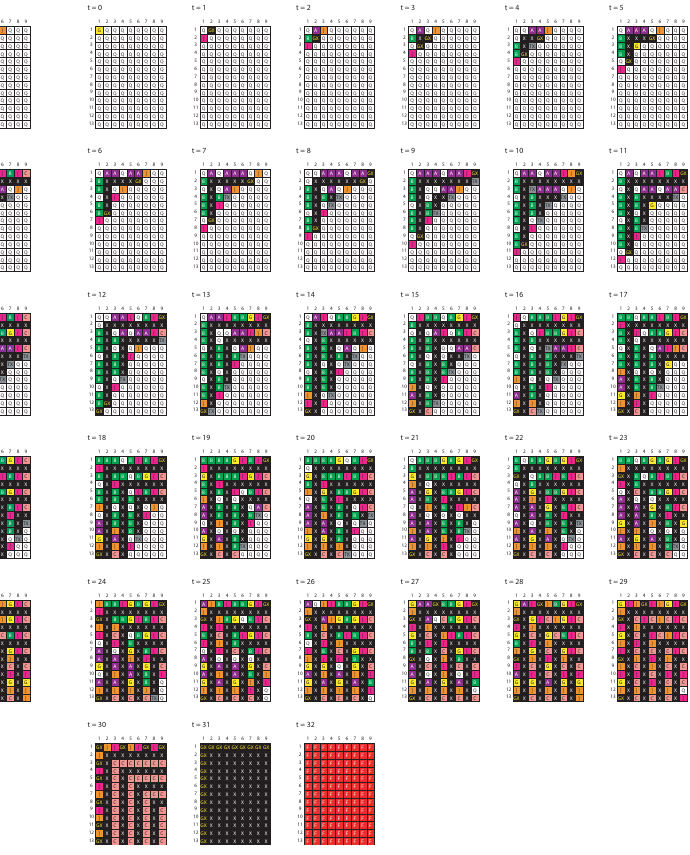
Fig. 5. Snapshots of the optimum-time eleven-state synchronization process on a 13 × 9 array.